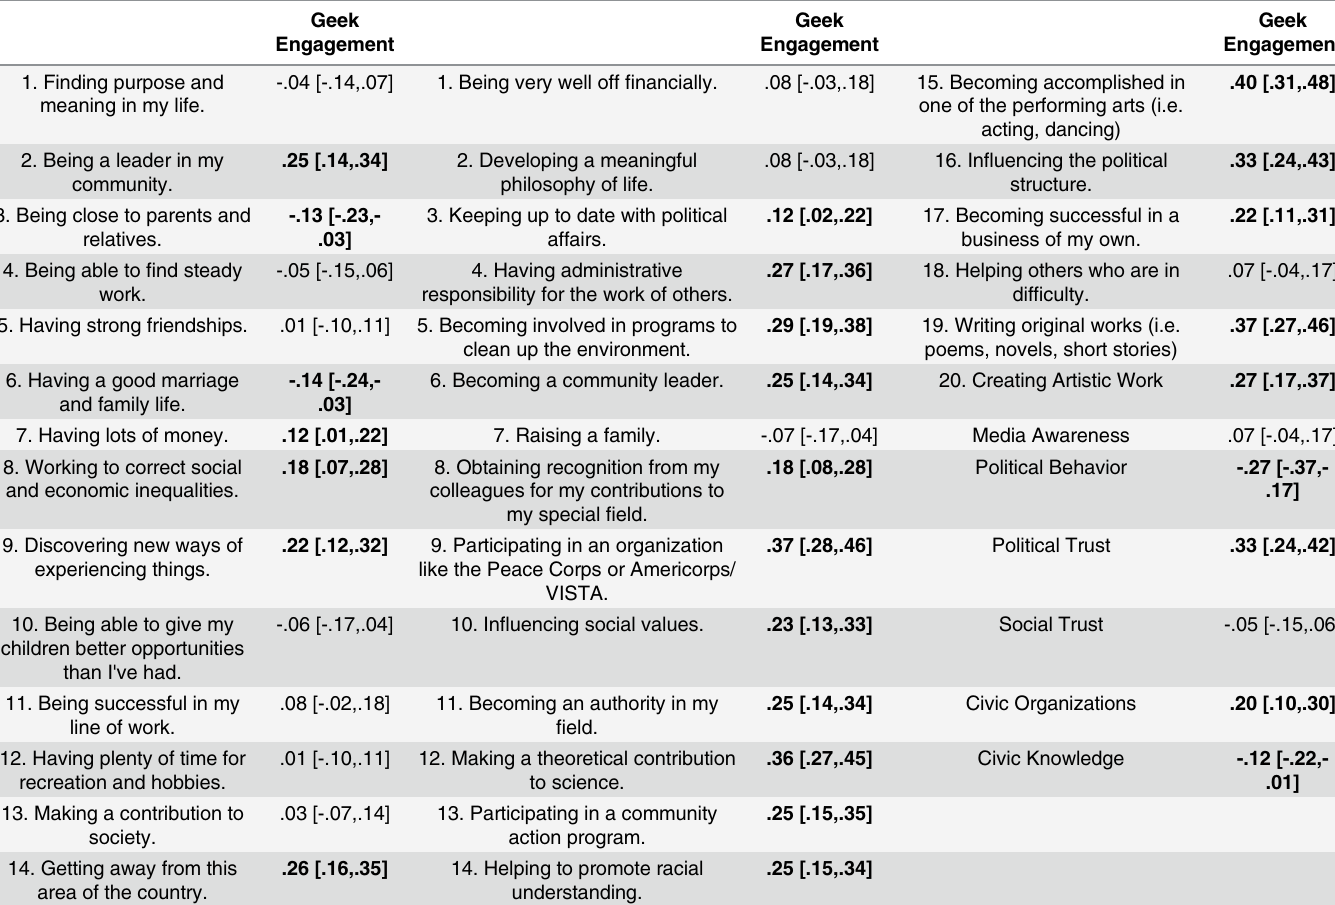
Table 6. Correlations between Geek Engagement and Life Goals Items from Twenge, Campbell, & Freeman (2012) and Civic Engagement Scores. Geek Engagement